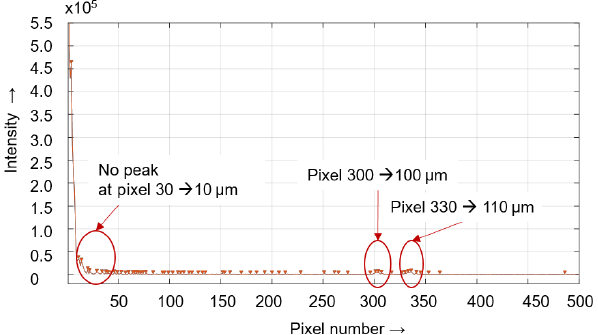
Figure 12. Spectrum of the lubricant BF152DL with a geometric layer thickness of